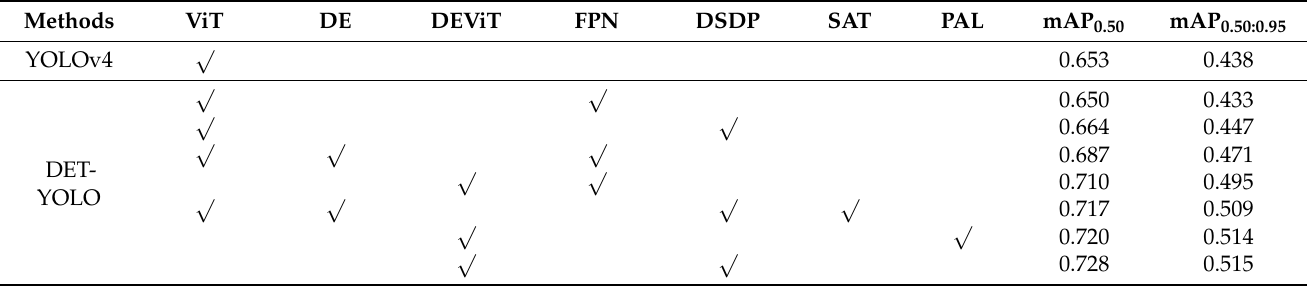
Table 8. The results of ablation experiments on DOTA